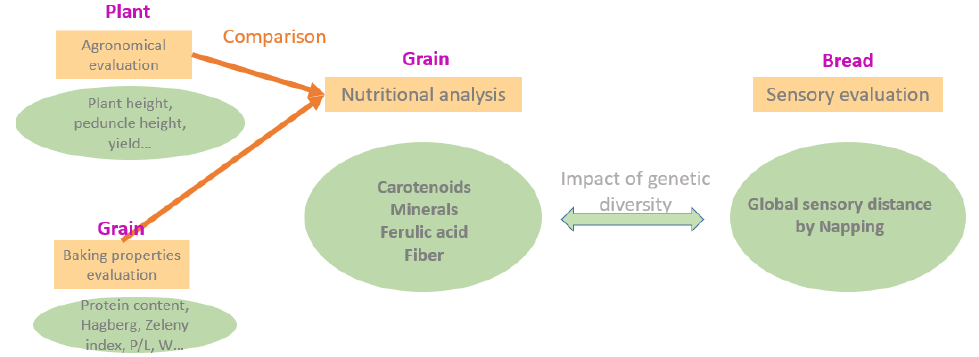
Figure 1. Graphical scheme of study approach.